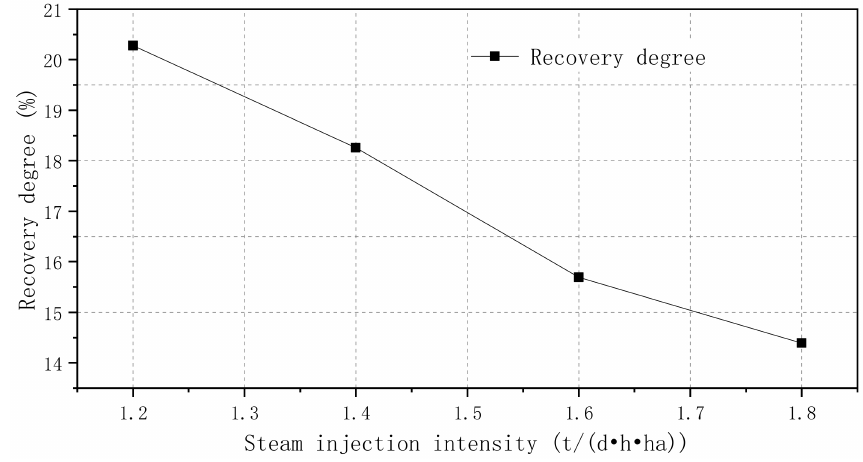
Figure 22. Recovery degree for different steam injection intensity. Table 7. Steam breakthrough time and recovery degree for different steam injection